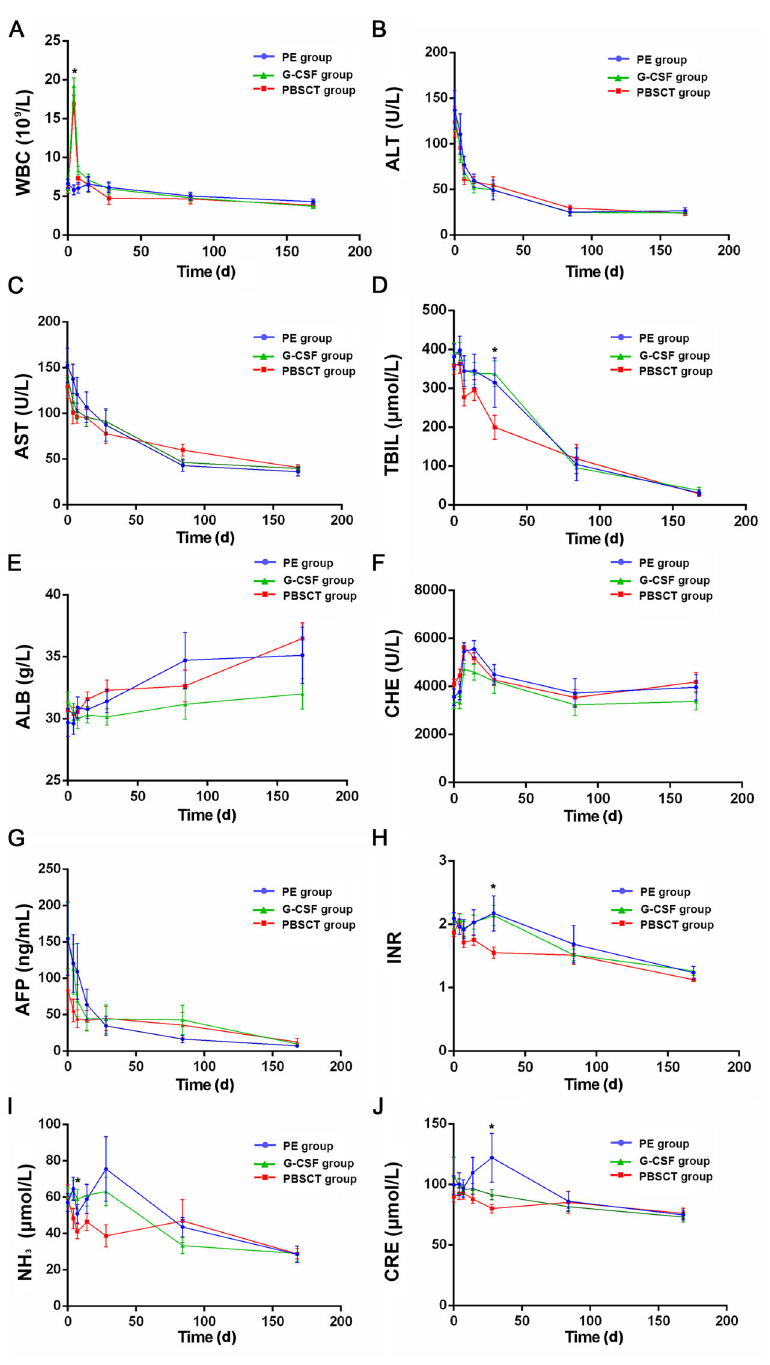
Figure 3. Changes of leucocyte levels and biochemical indexes in plasma exchange (PE), granulocyte colony-stimulating factor (G-CSF), and peripheral blood stem cell transplantation (PBSCT) groups. A , White blood cells (WBC) counts of G-CSF and PBSCT groups increased signi fi cantly on the fourth day of G-CSF treatment (*P o 0.05 vs the PE group). Increased WBC levels returned to normal after G-CSF treatment (all P 4 0.05 from 1 week forward). B – J , The levels of ammonia (NH 3 ) ( I ) showed signi fi cant differences in the fi rst week (*P o 0.05). The levels of alanine aminotransferase (ALT), aspartate aminotransferase (AST), total bilirubin (TBIL), albumin (ALB), cholinesterase (CHE), a -fetoprotein (AFP), international normalized ratio (INR), and creatinine (CRE) were also evaluated. Data are reported as means ± SD. *P o 0.05 (ANOVA with the LSD